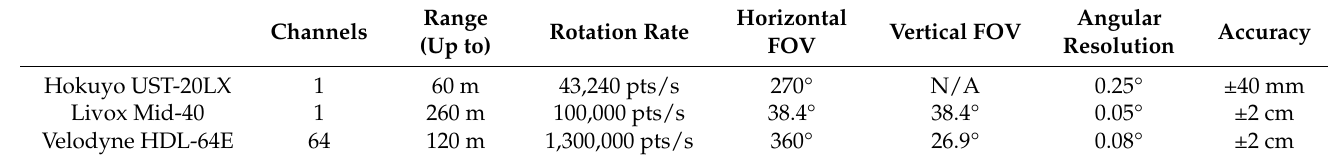
Table 1. Performance comparison between Hokuyo UST-20LX, Livox Mid-40 and Velodyne HDL-64E.